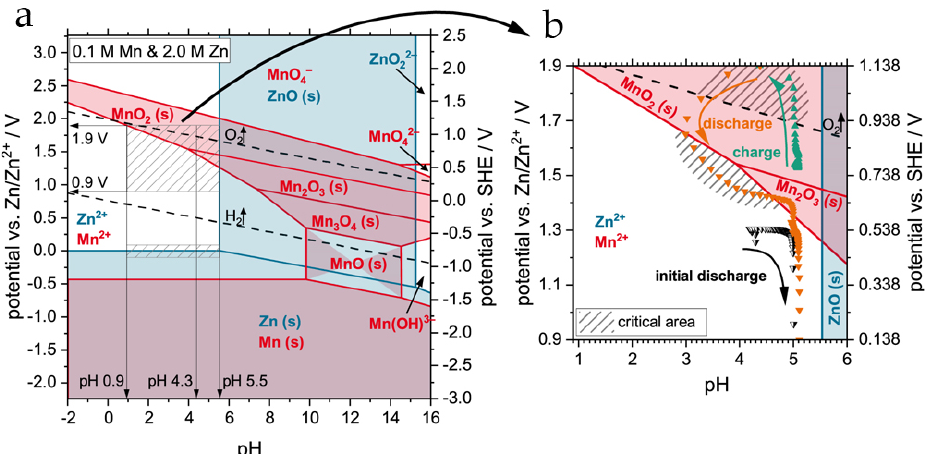
Figure 1 . ( a ) Thermodynamic operating window of the zinc-ion battery with respect to the pH value. ( b ) Zoomed area and pH-E plot of the cycling path of the battery cell with the 2 M ZnSO 4 /0.1 M MnSO 4 electrolyte (positive orientation, shaded area should be avoided for cycling) [20].